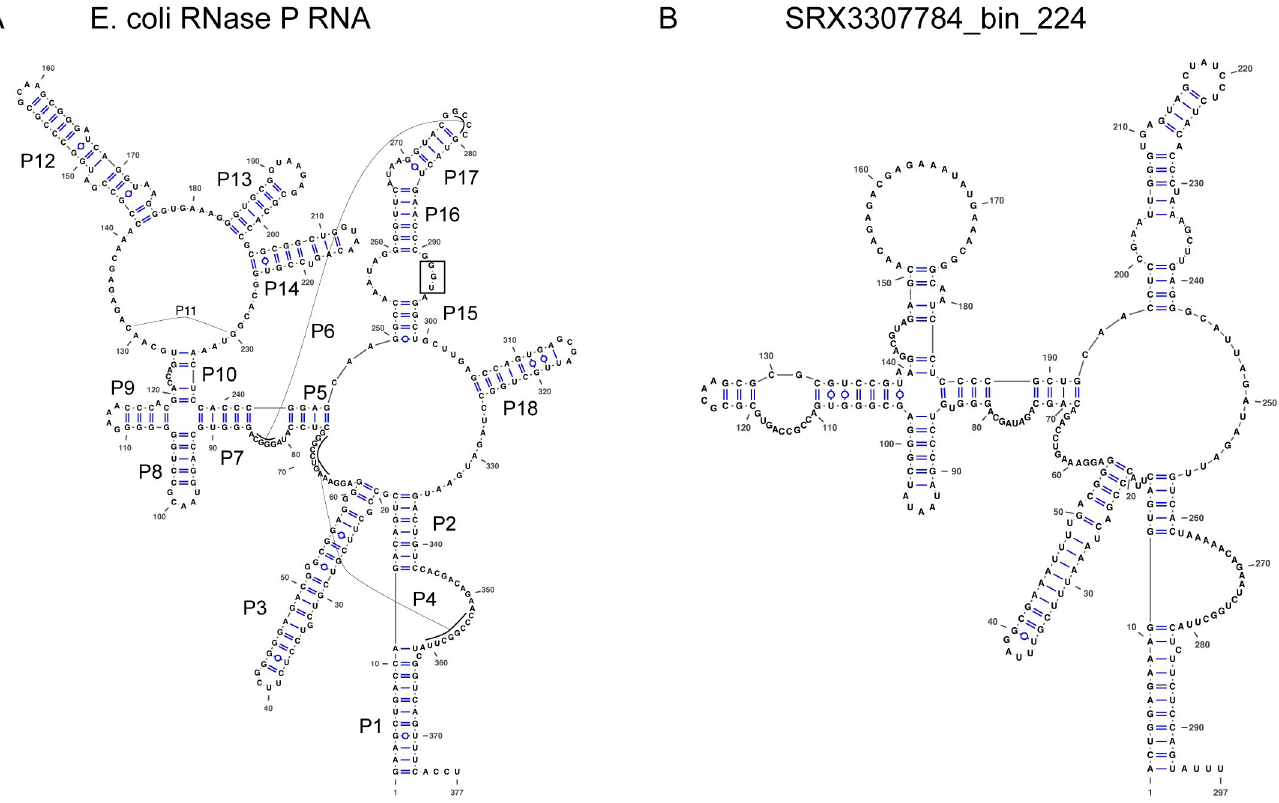
Fig 4. RNase P RNA can have diverged forms in CPR genomes. Structures were drawn using VARNA (Visualization Applet for RNA, http://varna.lri.fr/) [67]. (A) Structure of RNase P RNA from Escherichia coli K-12 substr. MG1655. Helices P1-P18 are labeled. The “UGG” sequence in the P15 loop that binds to the 3’ end of the pre-tRNAs is highlighted by a box. (B) Putative Structure of RNase P RNA from SRX3307784_bin_224 genome. Note that the P12, P13, P14, and P18 helices are missing, as well as the UGG motif. Although it is not uncommon for P13, P14, and P18 to be missing in various bacteria, it is unusual that P12 is missing. To compare the two structures, large regions of the RNA had to be refolded manually from the original cmsearch prediction.